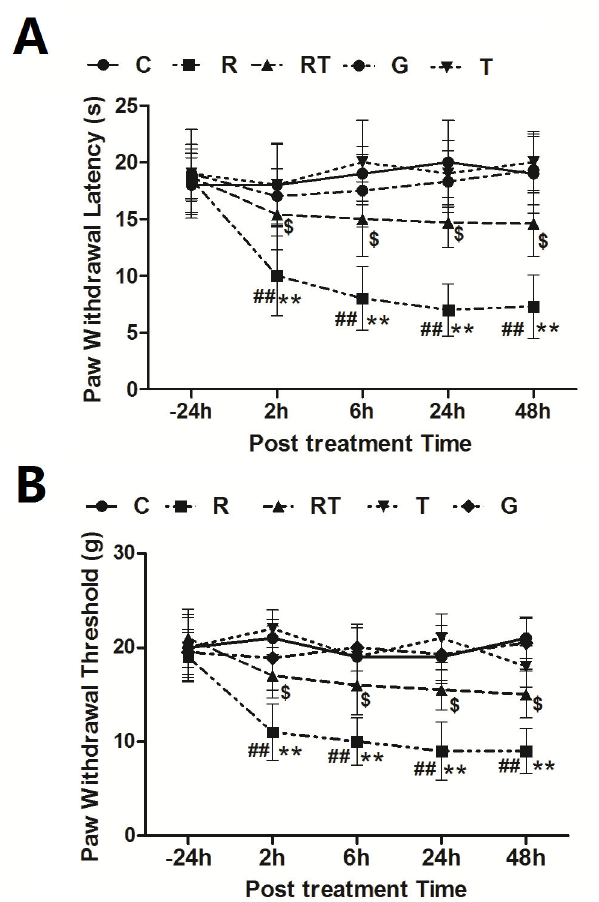
Figure 1. GSK-3β inhibition prevents remifentanil-induced thermal (A) and mechanical (B) hyperalgesia. Sixty adult rats were randomly divided into 5 groups (n = 12 in each group): saline group (C group, 0.1 ml·kg -1 ·min -1 , 60 min, iv),